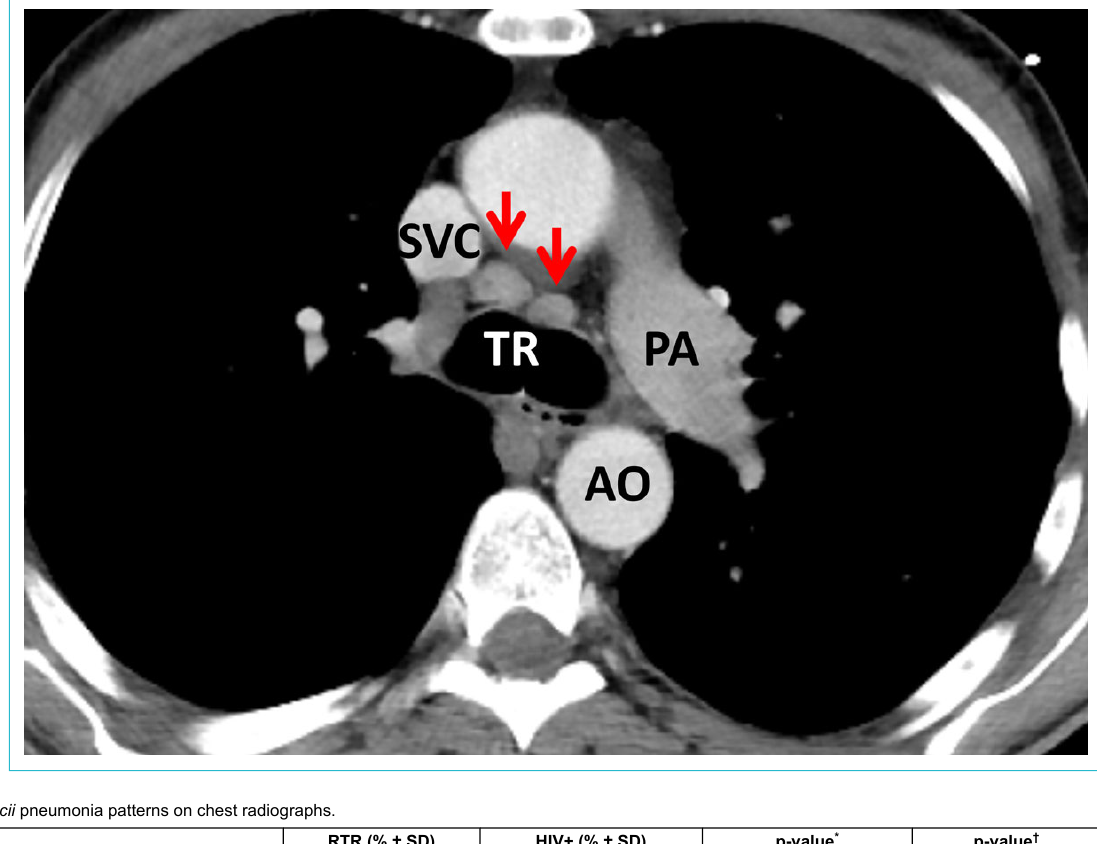
Figure 3: Axial cross section image in soft tissue window at the level of the carina in a human immunodeficiency virus (HIV)-positive patient with Pneumocystis jirovecii pneumonia (PJP). There is mediastinal lymph node enlargement at the left and right lower paratracheal nodal sta-